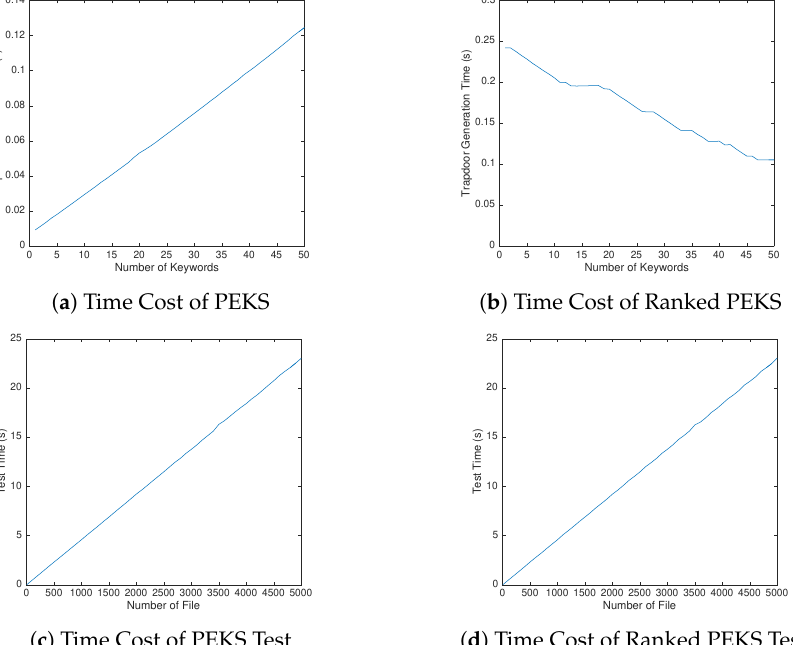
Figure 10. Time cost of our